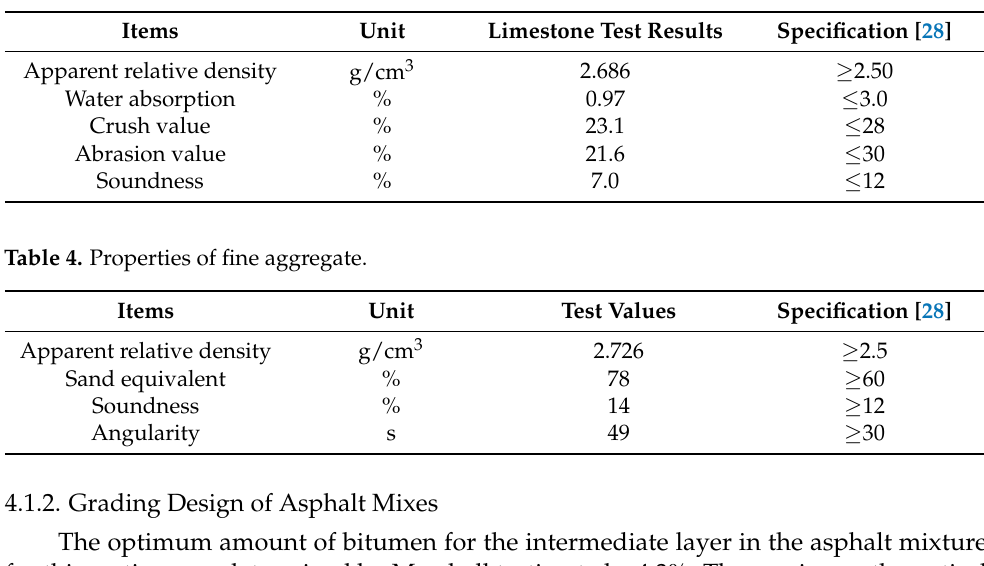
Table 3. Properties of coarse aggregate.